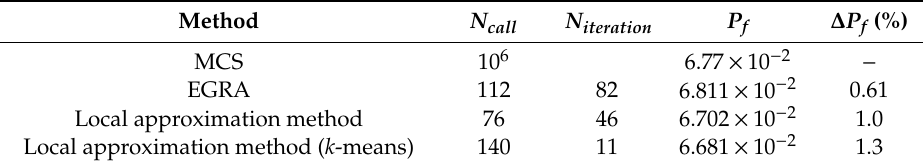
Table 7. Results of the reliability analysis of Example